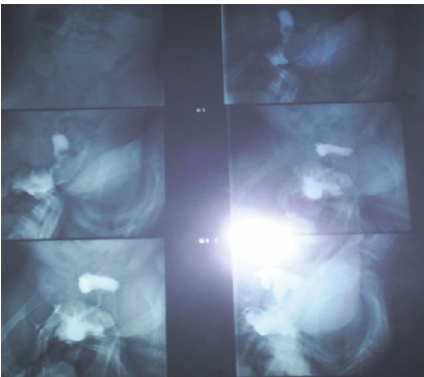
Figure 3: Genitography: female urethra, vaginal and uterine cavity, and fallopian